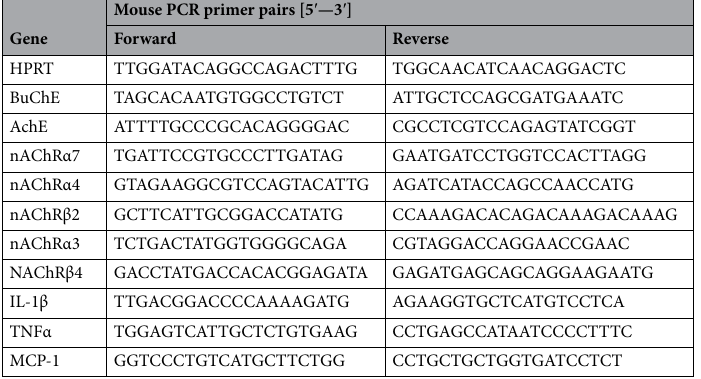
Table 5. Primer pair sequences used in the